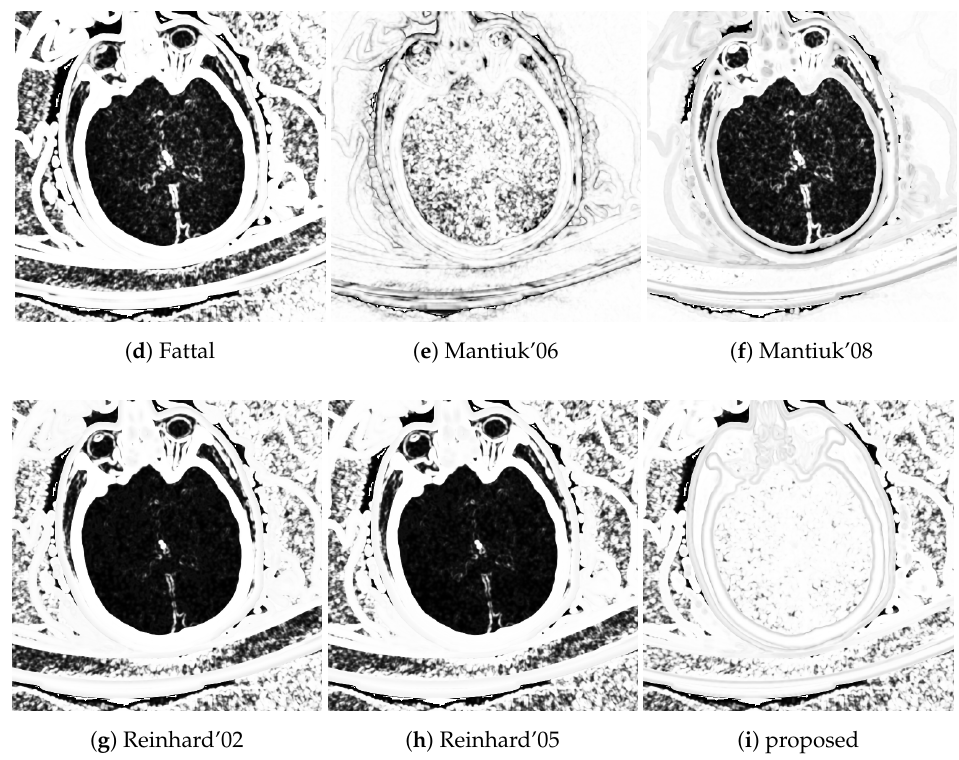
Figure 9. Structural similarity map for the head CT example. Brighter shades belong to higher local structural similarity (white = 1.0, black =